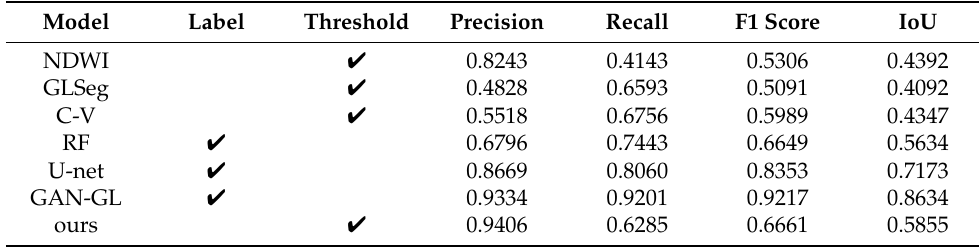
Table 4. Evaluation results of segmentation methods weather it involves label or threshold.